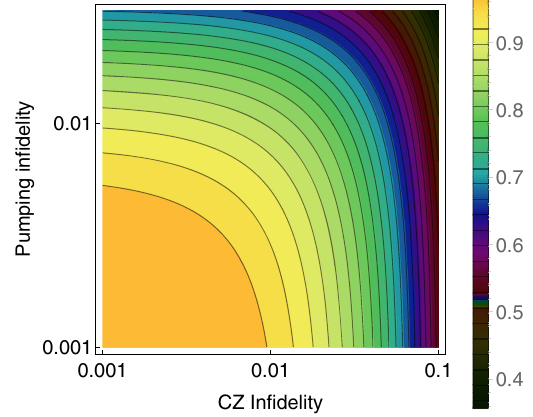
FIG. 8. The fidelity of the N ¼ 6 RGS shown in Fig. 1 as a function of the infidelity of the two-qubit CZ gate and the optical pumping infidelity. (The fidelity of single-qubit gates is taken to be 99.9%.)